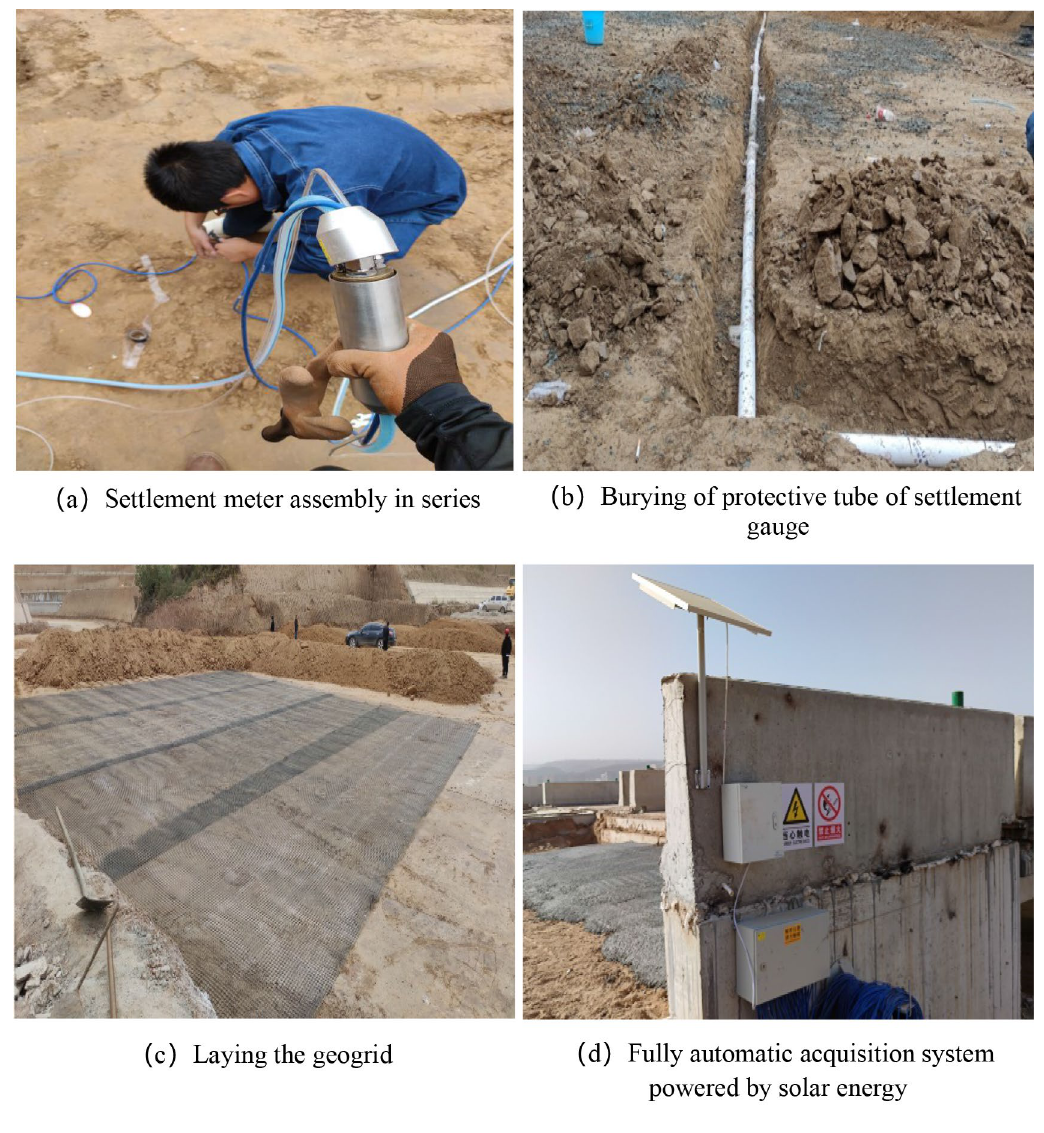
Figure 3. Installation of the profile settlement